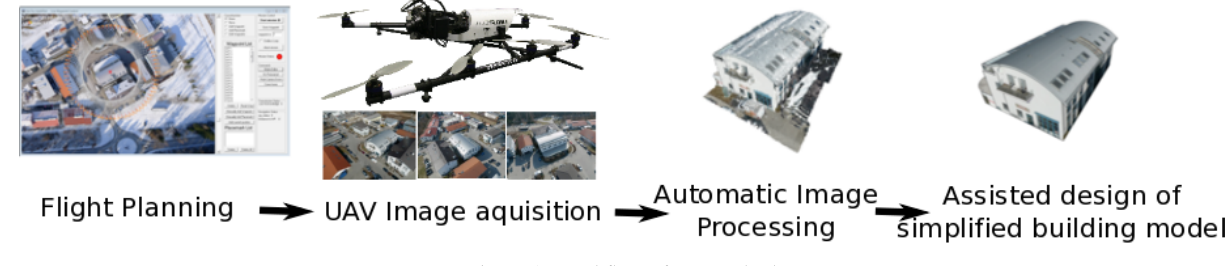
Figure 1: Workflow of our